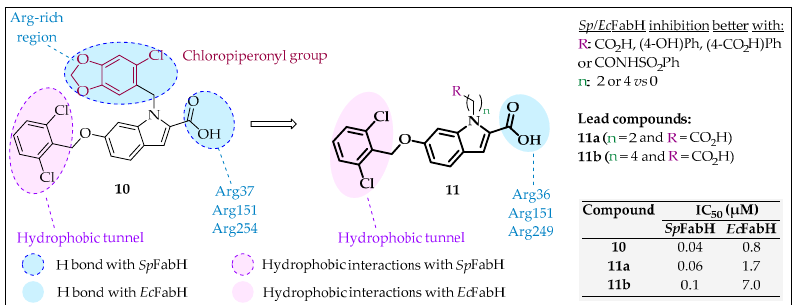
Figure 11. Structures, SAR and representation of main interactions with Sp FabH and Ec FabH of indole analogues 10 and 11 and in vitro activities of lead compounds [42].